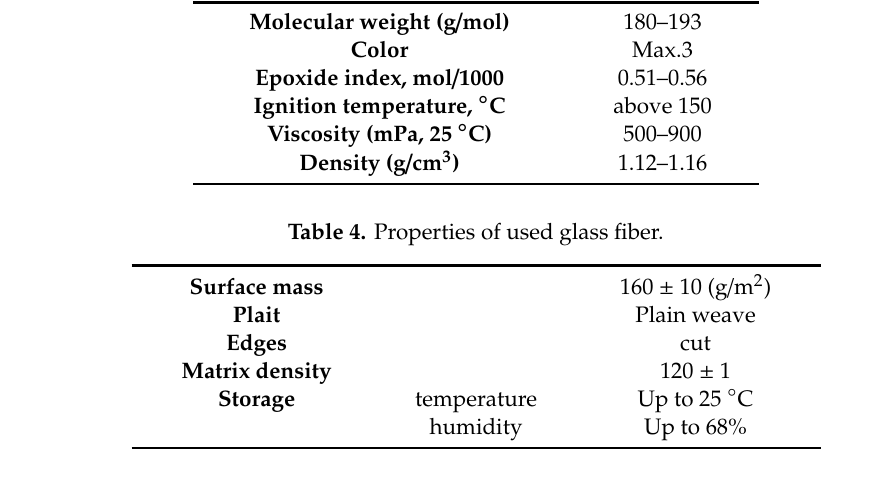
Table 5. Properties of a used polyurea